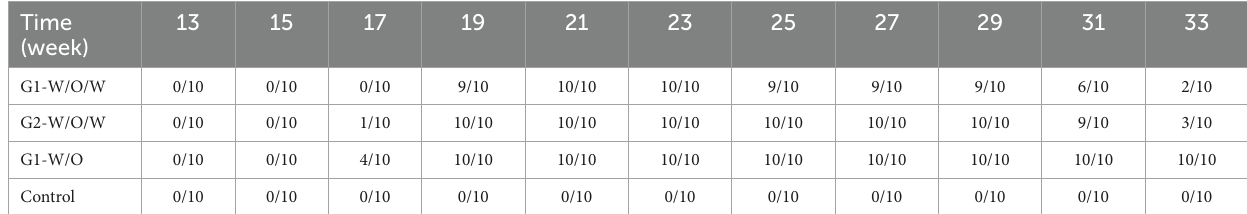
TABLE 3 The validity statistics of at different periods